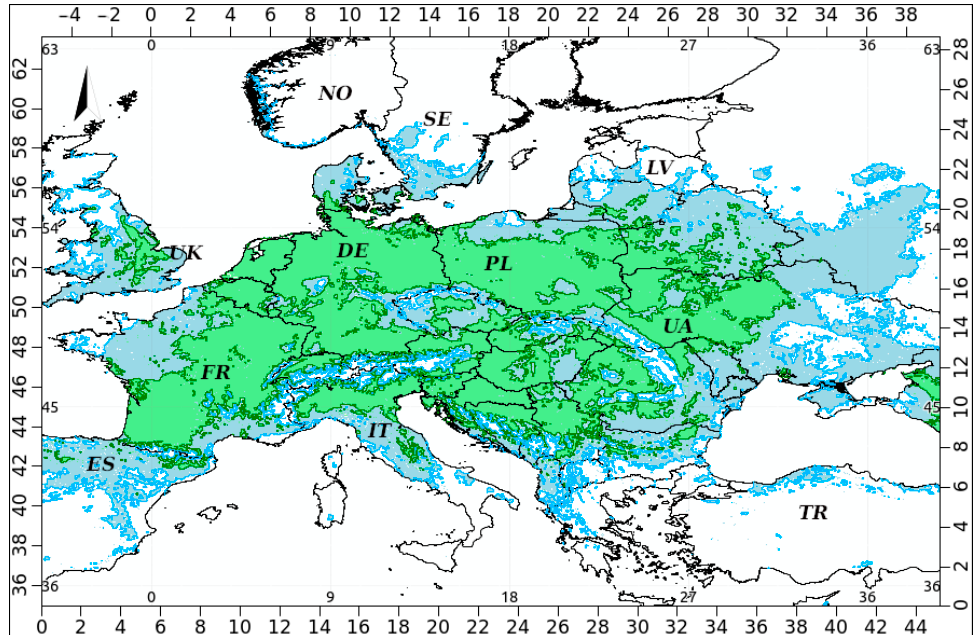
Figure 7. Map of the potential distribution P. robiniella in Europe. Areas within the 10th percentile threshold are colored in green; areas within the 1st percentile threshold are colored in blue; country codes: France (FR), Germany (DE), Italy (IT), Latvia (LV), Norway (NO), Poland (PL), Spain (ES), Sweden (SE), Turkey (TR), United Kingdom (UK), Ukraine (UA).